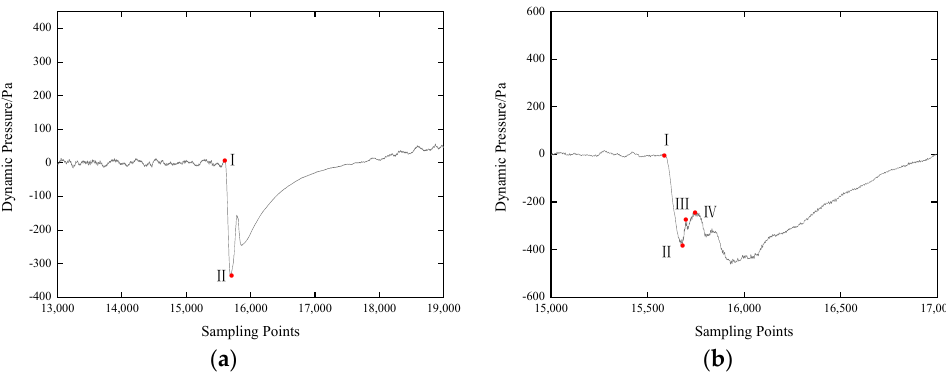
Figure 12. Dynamic pressure curve after introducing disturbance signals into the pipeline with a leakage hole: ( a ) sensor 1; ( b ) sensor 4.